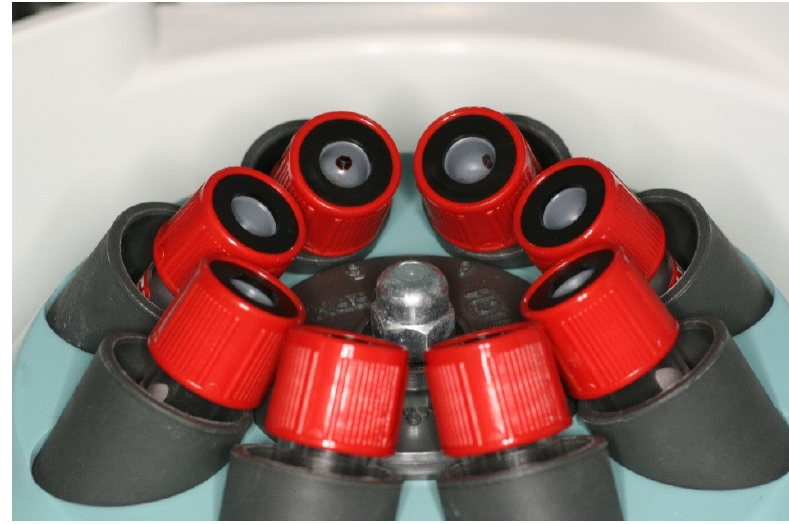
Figure 1. Single-use vacutainers filled with venous blood prepared for centrifugation.